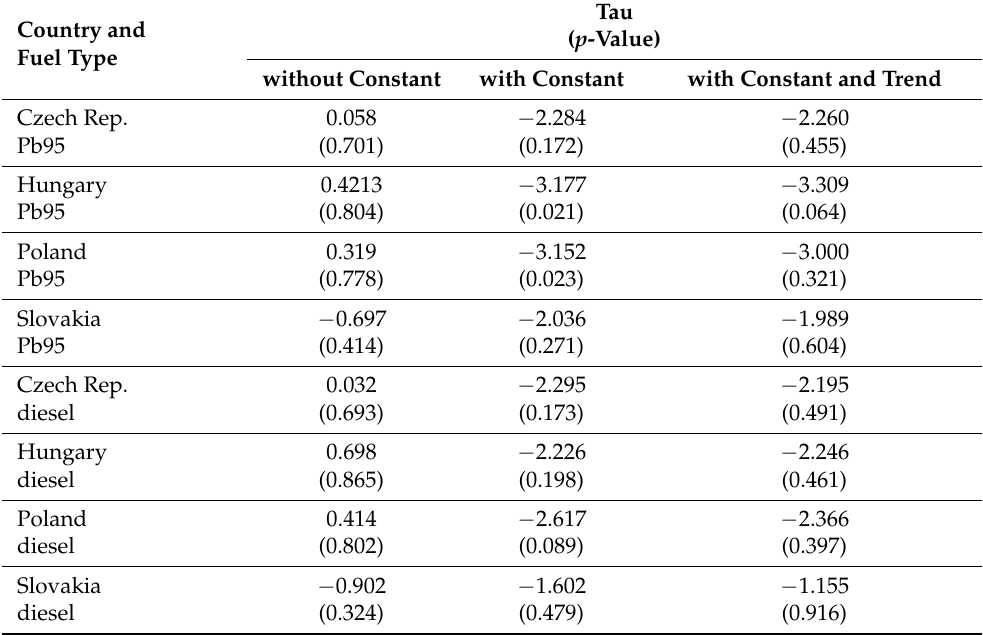
Table 4. The ADF test results for fuel